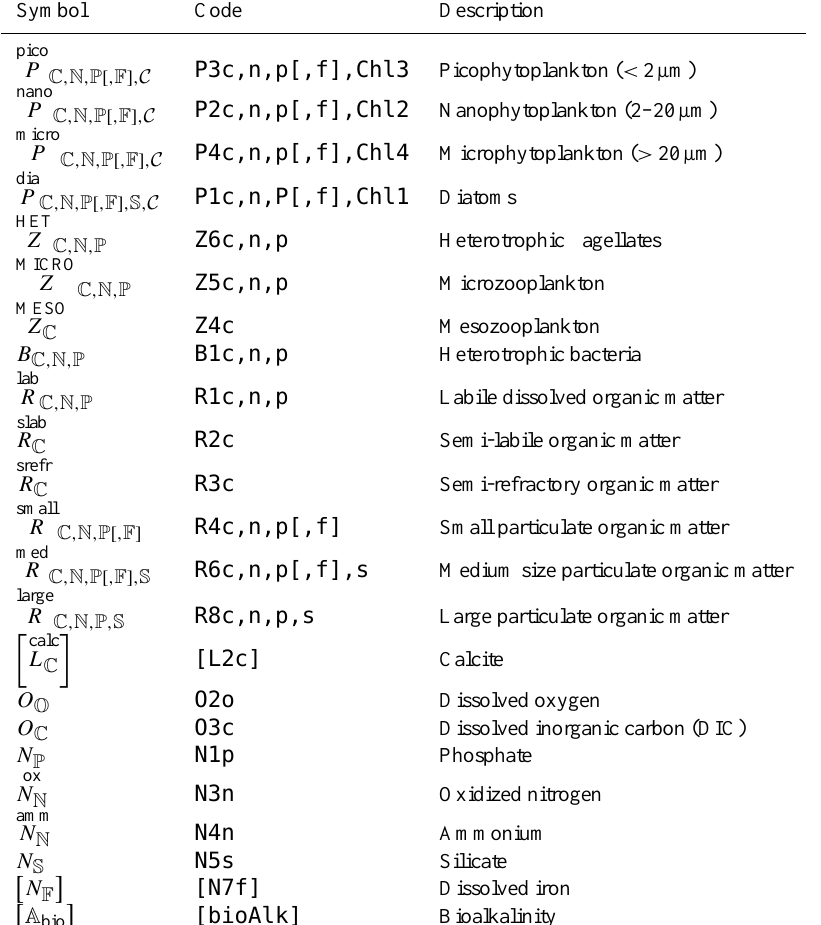
Table 1. Pelagic functional types and their components (squared brackets indicate optional states) – chemical components: C carbon, N ni- trogen, P phosphorus, F iron, S silicate, C chlorophyll a